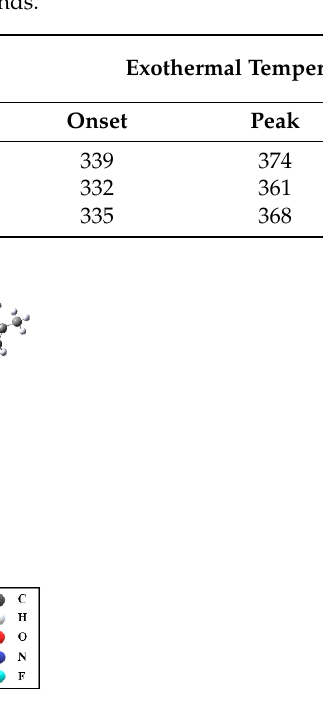
Figure 14. Energy minimized structures and natural bond orbital (NBO) charge of ethynyl group of simplified ( a ) MC–O, ( b ) MC–F and ( c ) MC–P.